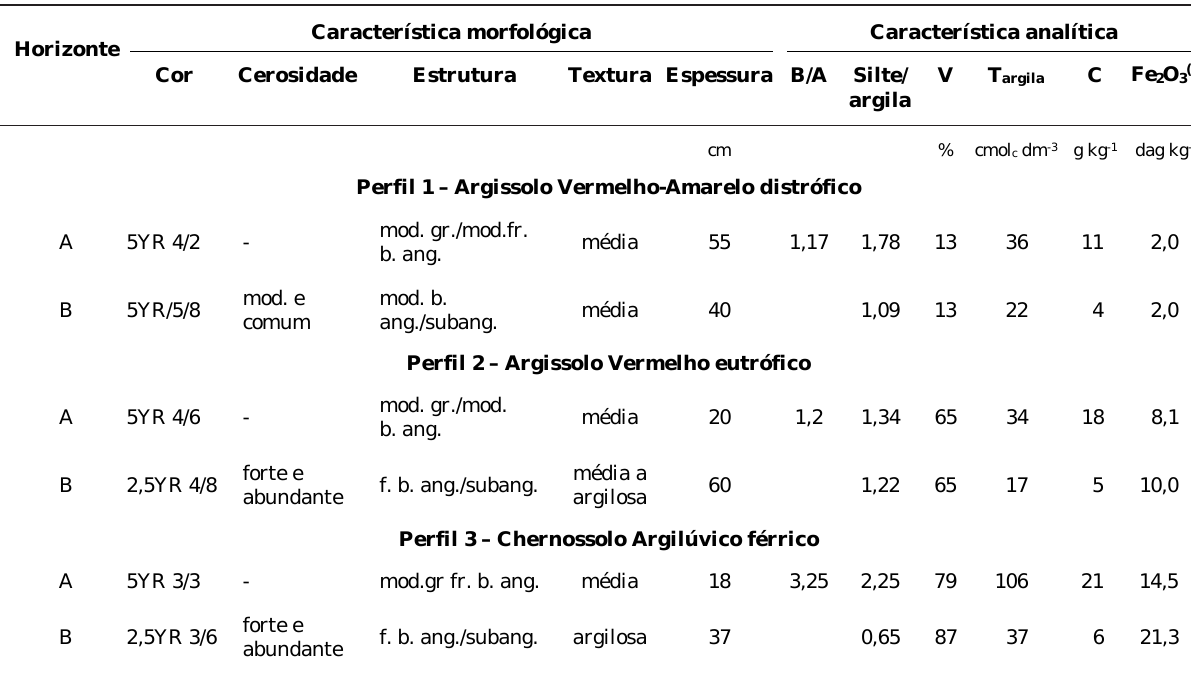
(1) extraído pelo ataque sulfúrico, mod. = moderada, f. = forte, fr. = fraca, gr. = granular, b. = blocos, ang. = angulares, subang. = subangulares, B/A = relação textural de argila entre os horizontes B e A, V = saturação por bases da CTC a pH 7, T (CTC) da argila, C = carbono orgânico.